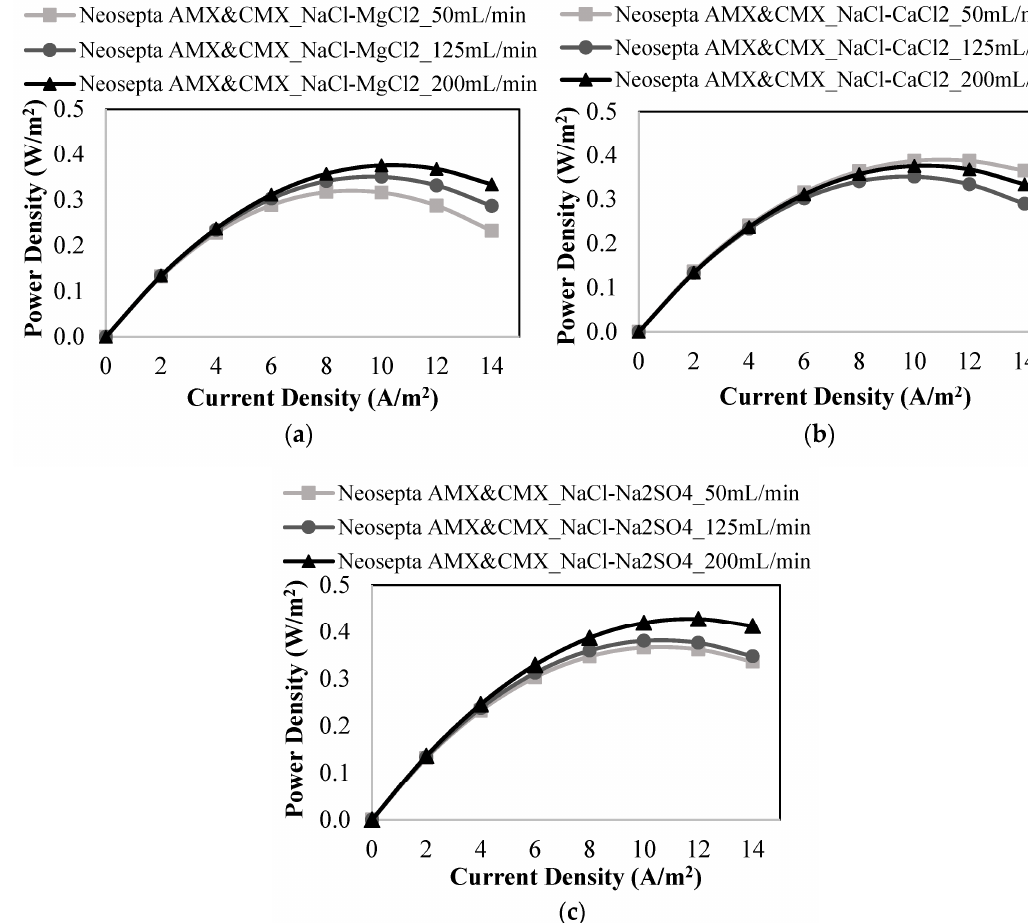
Figure 7. Power density vs. current density plots at different feed flow rates for the studies performed with ( a ) a mixture of NaCl and MgCl 2 , ( b ) a mixture of NaCl and CaCl 2 , ( c ) a mixture of NaCl and Na 2 SO 4 using Neosepta AMX & CMX membranes. Table 7. Power density and OCV results of the studies performed by Neosepta AMX and Neosepta CMX membranes.